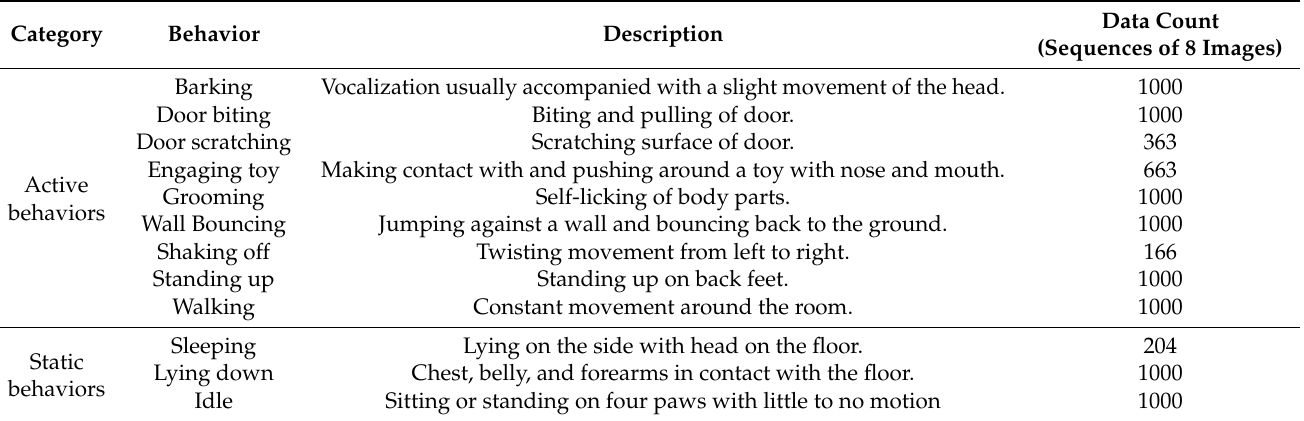
Table 3. Dog behavior description and dataset used for the behavior recognition model